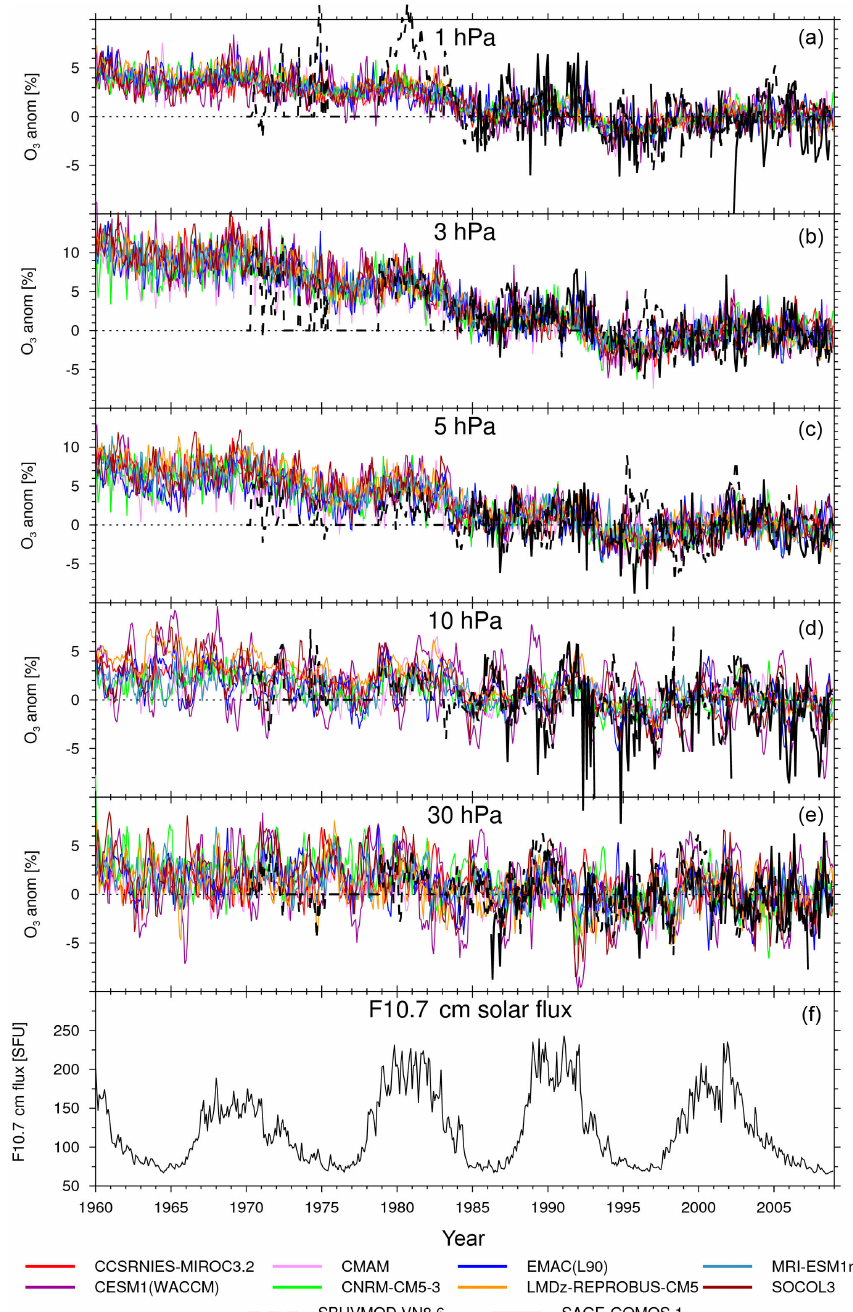
Figure 2. Time series of deseasonalized percent tropical (30 ◦ S–30 ◦ N) ozone anomalies in CCMI-1 models for 1960–2009 and two satellite datasets at (a) 1hPa, (b) 3hPa, (c) 5hPa, (d) 10hPa and (e) 30hPa. The lowest panel shows the F10.7cm solar flux for reference. Anomalies are shown relative to a baseline period